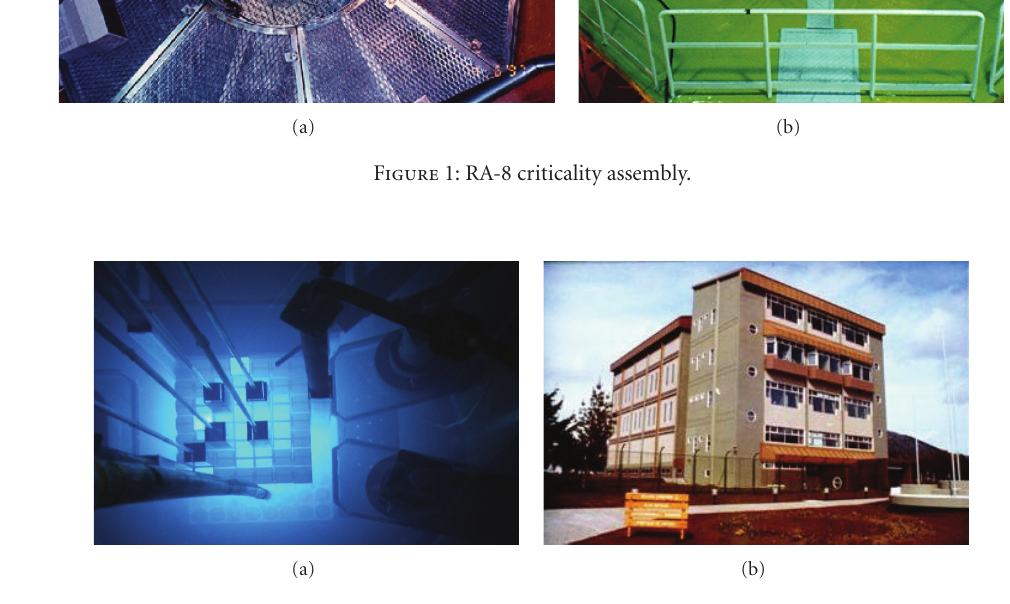
Figure 2: RA-6 research